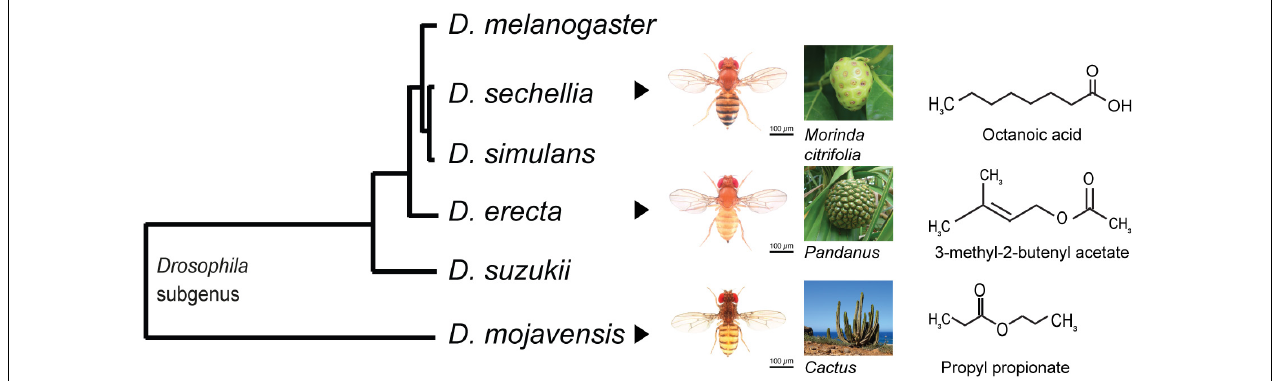
FIGURE 2 | Phylogenetic tree of several Drosophila species with their hosts and the key host volatiles. Drosophila sechellia can tolerate the octanoic acid emitted by its host Morinda citrifolia . The seasonal specialist Drosophila erecta is attracted to its host Pandanus by the volatile 3-methyl-2-butenyl acetate. Drosophila mojavensis is attracted by the propyl propionate emitted from its host cactus. Drosophila images are from Nicolas Gompel; host images were taken from